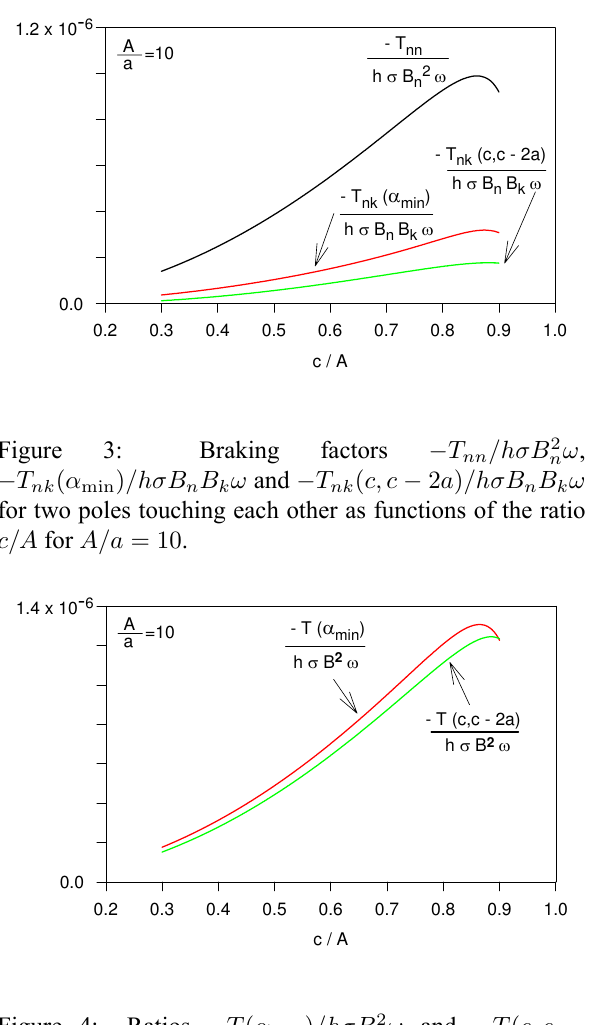
Figure 4: Ratios − T ( α min ) /hσB 2 ω and − T ( c, c − 2 a ) /hσB 2 ω for the total torque per pole as functions of the ratio c/A for the two poles touching each other at the az- imuthal (red curve) and radial (green curve) arrangements. 2 a ) = [( T 11 ( c ) + T 22 ( c − 2 a ) + 2 T 12 ( c, c − 2 a )] / 2